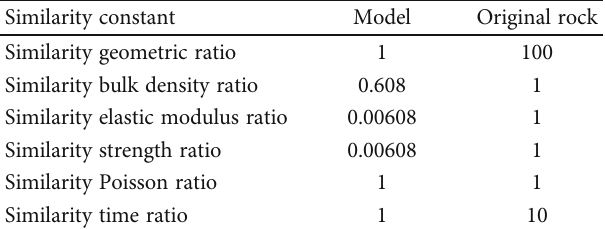
Table 1: List of similar constants of the